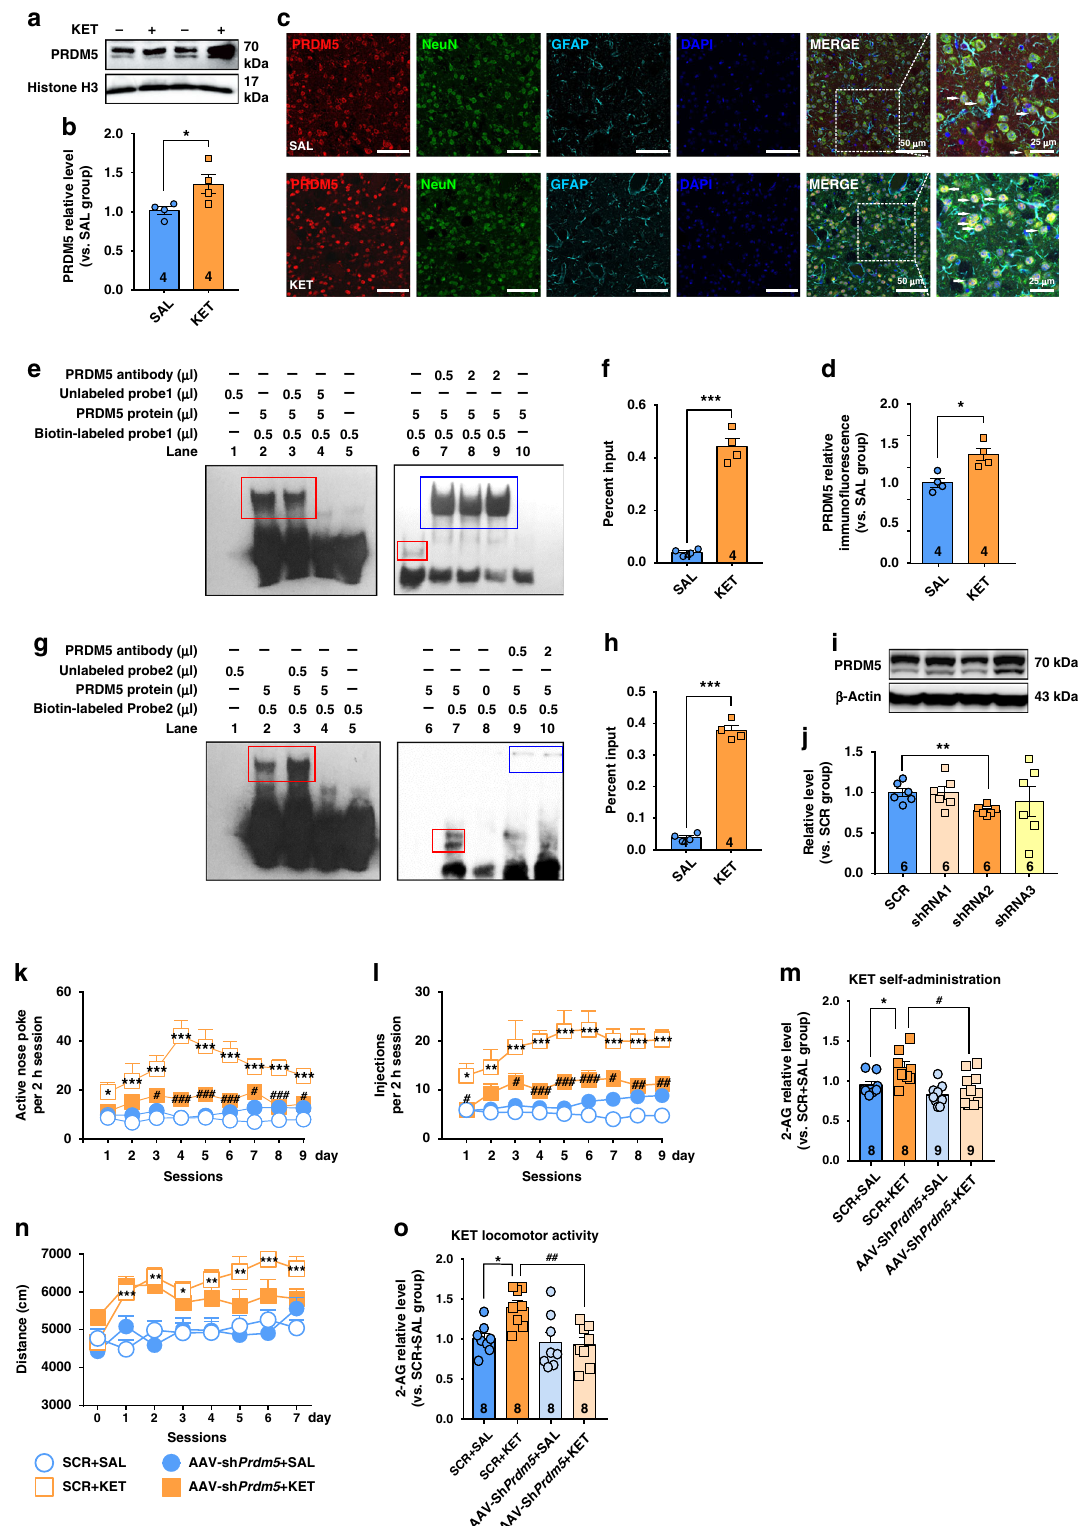
e PRDM5 antibody ( μ l) Unlabeled probe1 ( μ l) PRDM5 protein ( μ l) Biotin-labeled probe1 ( μ